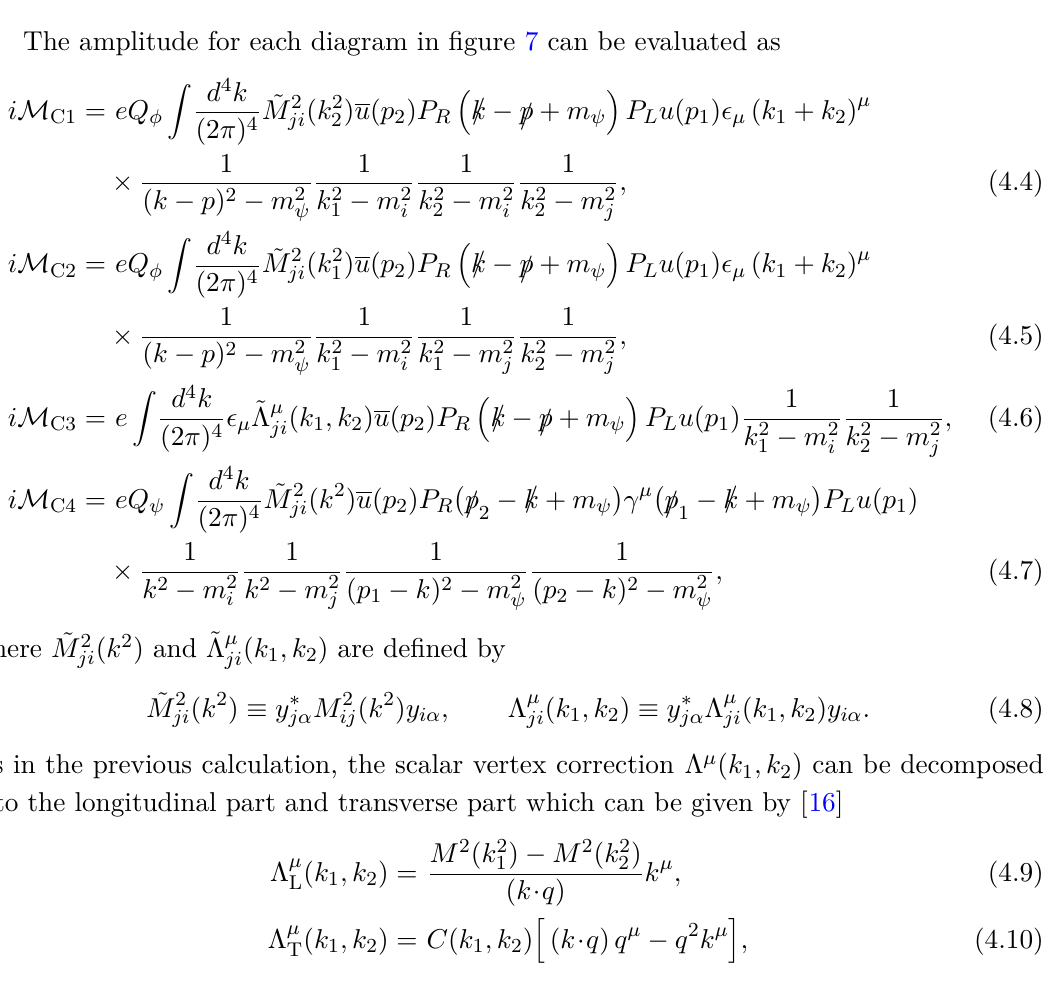
Figure 7 . Feynman diagrams which may contribute to EDMs of the fermions f α with multi-scalars φ i and a fermion ψ